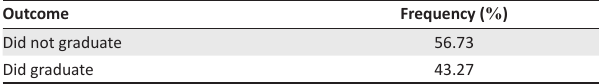
TABLE 4: Observed graduation rates at the university over the period